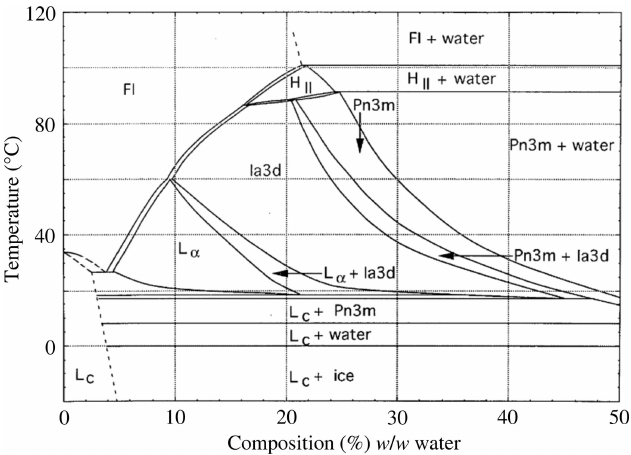
Figure 1 Temperature–composition phase diagram of the monoolein/water system. Reprinted with permission from Briggs et al. (1996), Copyright 2000 by